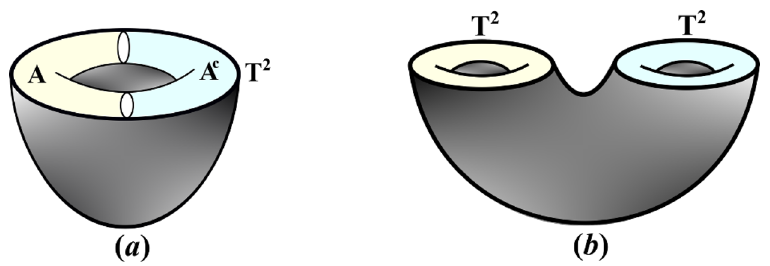
Figure 1. Two ways of computing topological entanglement entropy: the manifold in ( a ) has a single T 2 boundary, which is bi-partitioned into spatially connected regions A and A c . The manifold in ( b ) has two disjoint T 2